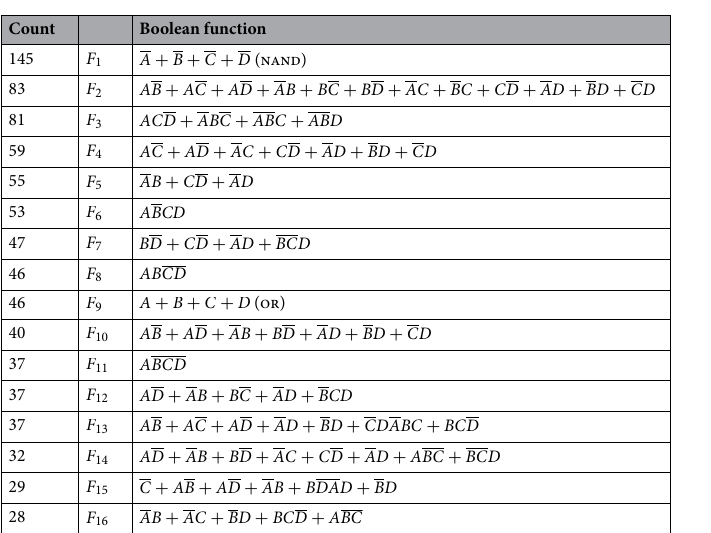
Table 1. Top 16 highest occurring Boolean